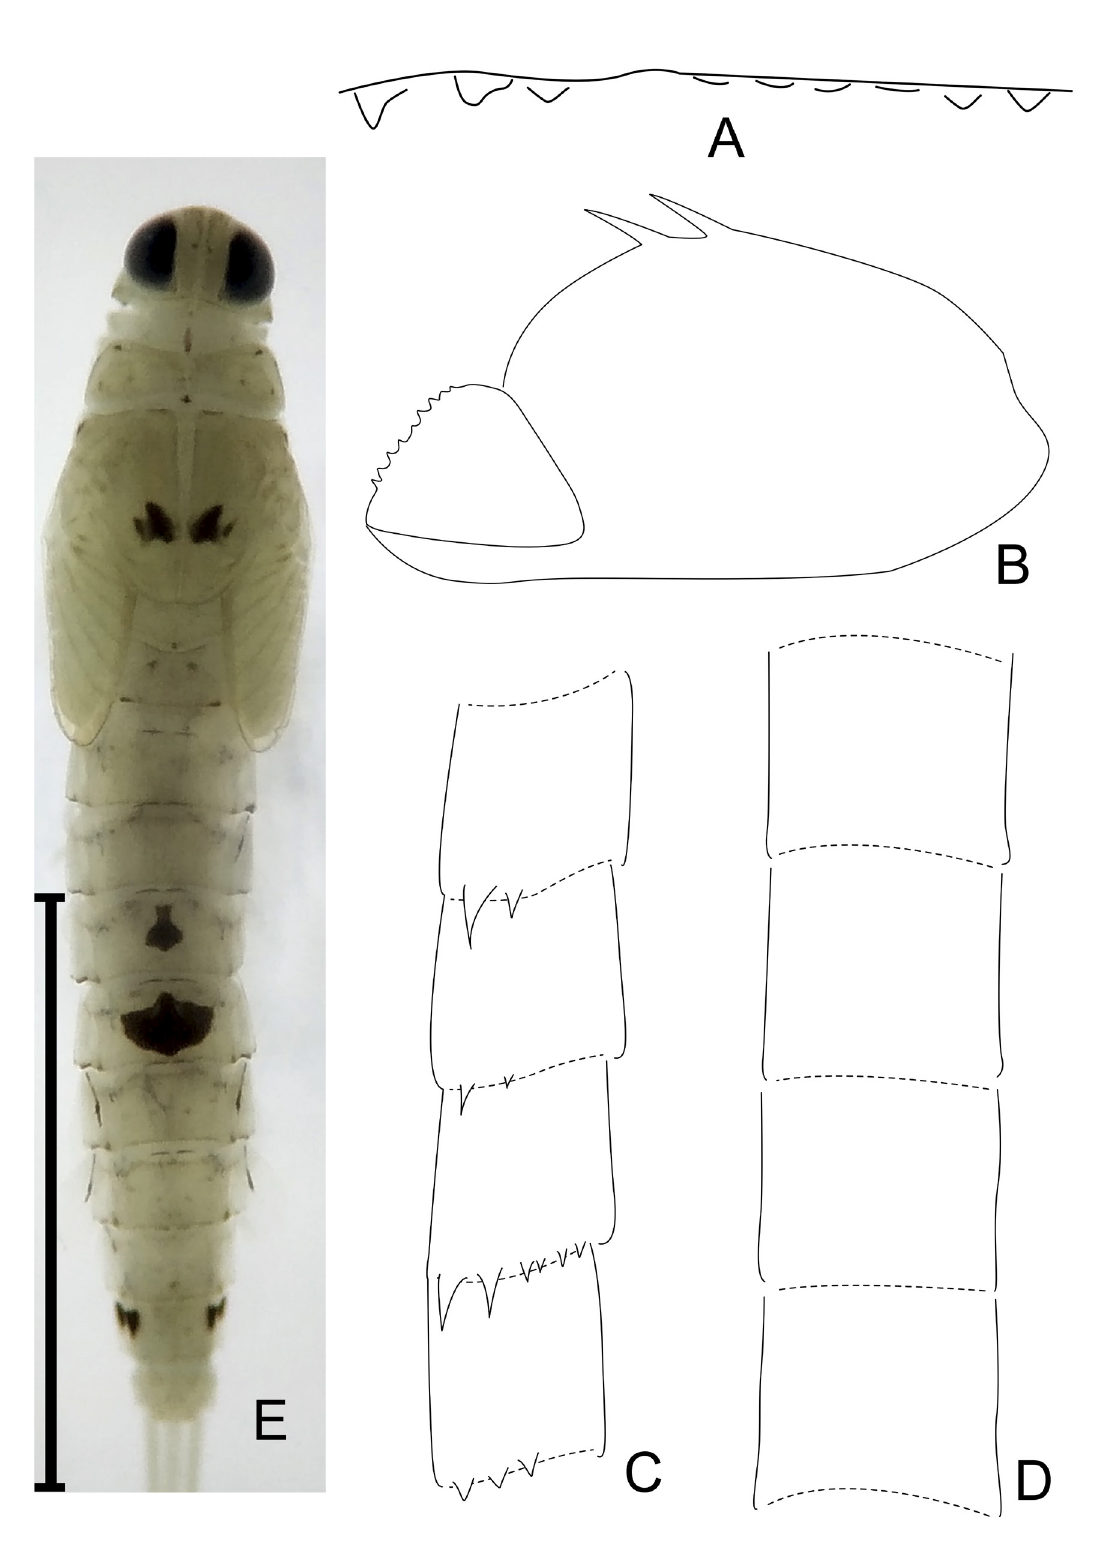
Fig. 18. Rivudiva naia sp. nov., holotype (UFRR). A . Margin of tergum IV. B . Paraproct. C . Cercus. D . Paracercus. E . Dorsal habitus of female nymph. Scale bar: E = 2.0 mm; A–D not to